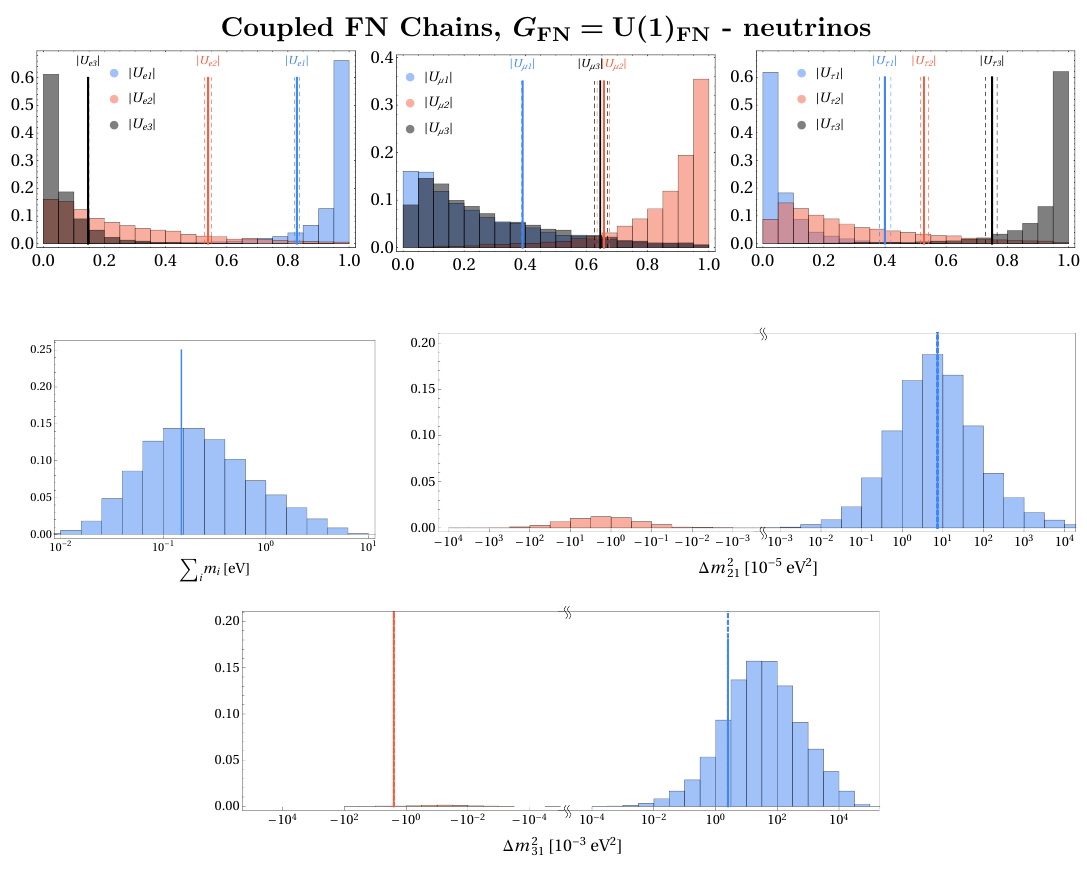
Figure 12 . The same as in (cid:12)gure 11, but for the coupled FN chains, G FN = U(1) FN . Here we use (cid:3) LN = 10 13 GeV, see text for